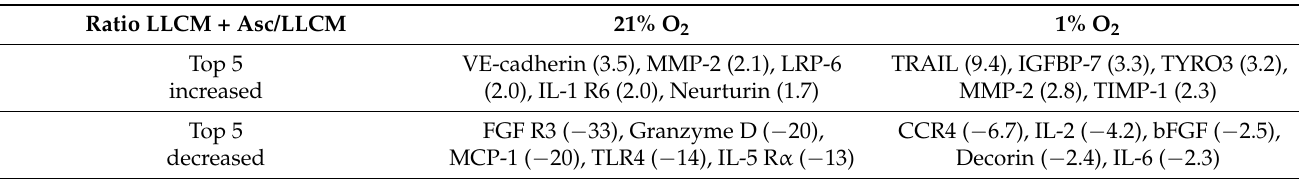
Table 1. Top ten secreted proteins differentially regulated by ascorbate in media conditioned by BMDM cultured at 21% and 1% O 2